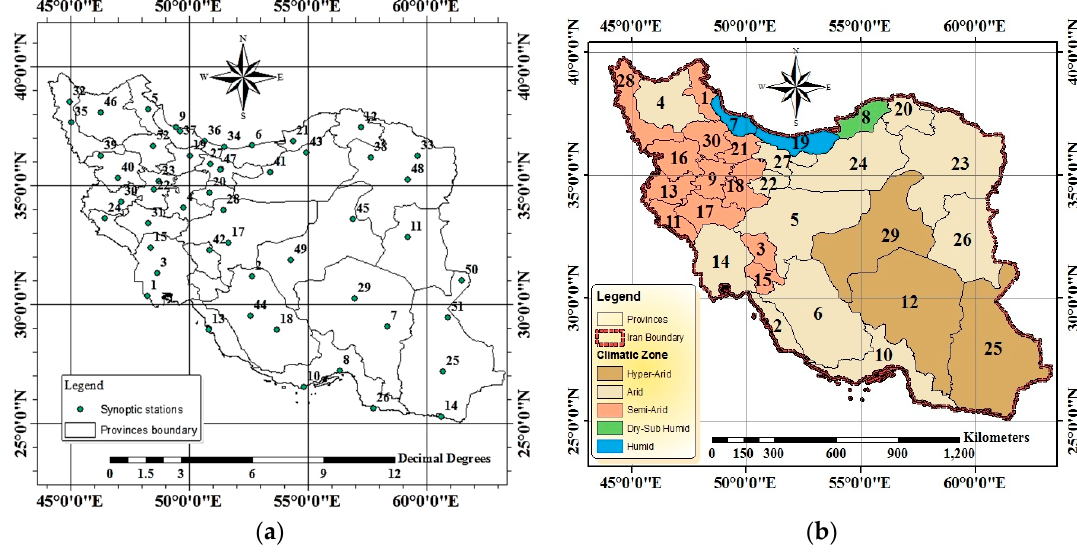
Figure 1. Provinces and the 52 weather stations ( a ) and the climatic regions of Iran ( b ).